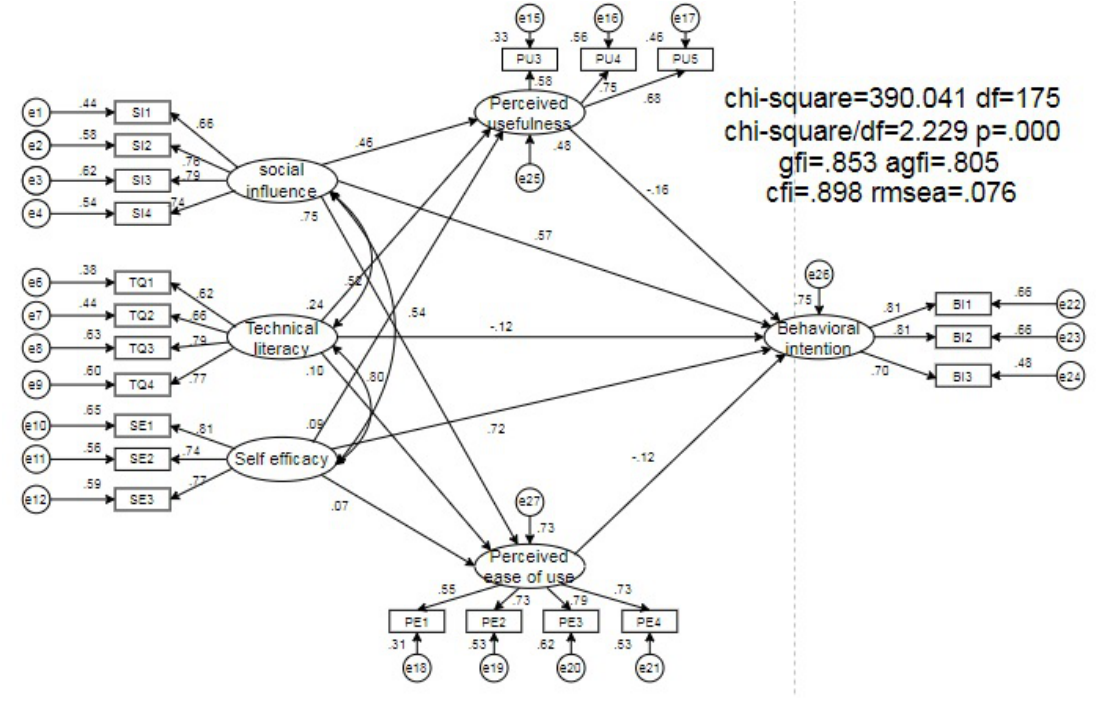
Fig. 8 Modified validation factor analysis